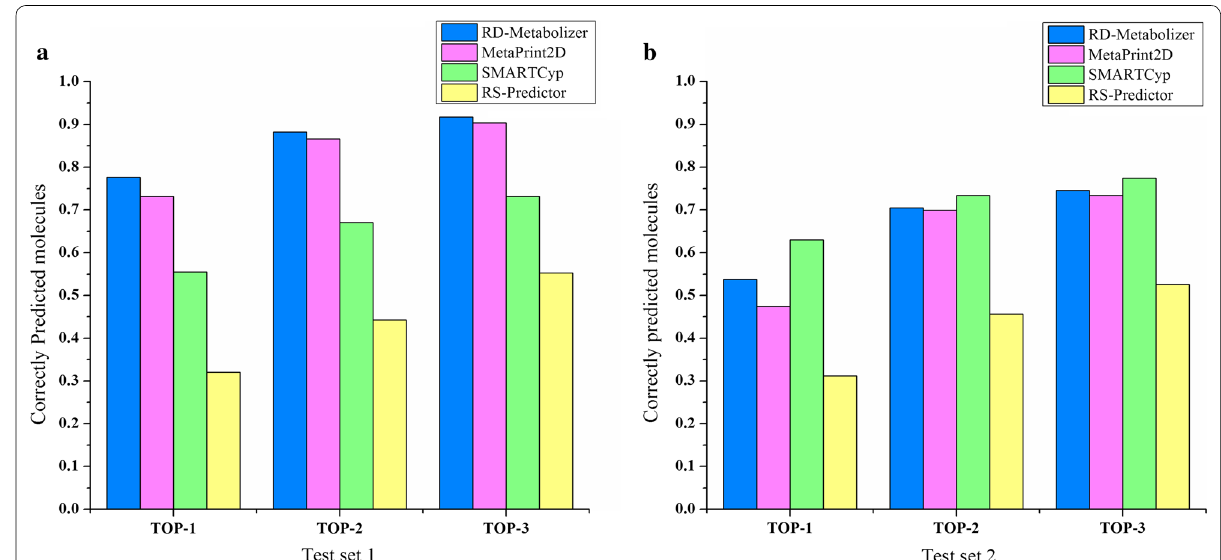
Fig. 3 Comparison of SOM prediction performance of RD-Metabolizer and other predictors. Histograms show the correct prediction ratios a for test set 1 and b for test set 2 at the top- k ( k 1, 2, 3) metric, =